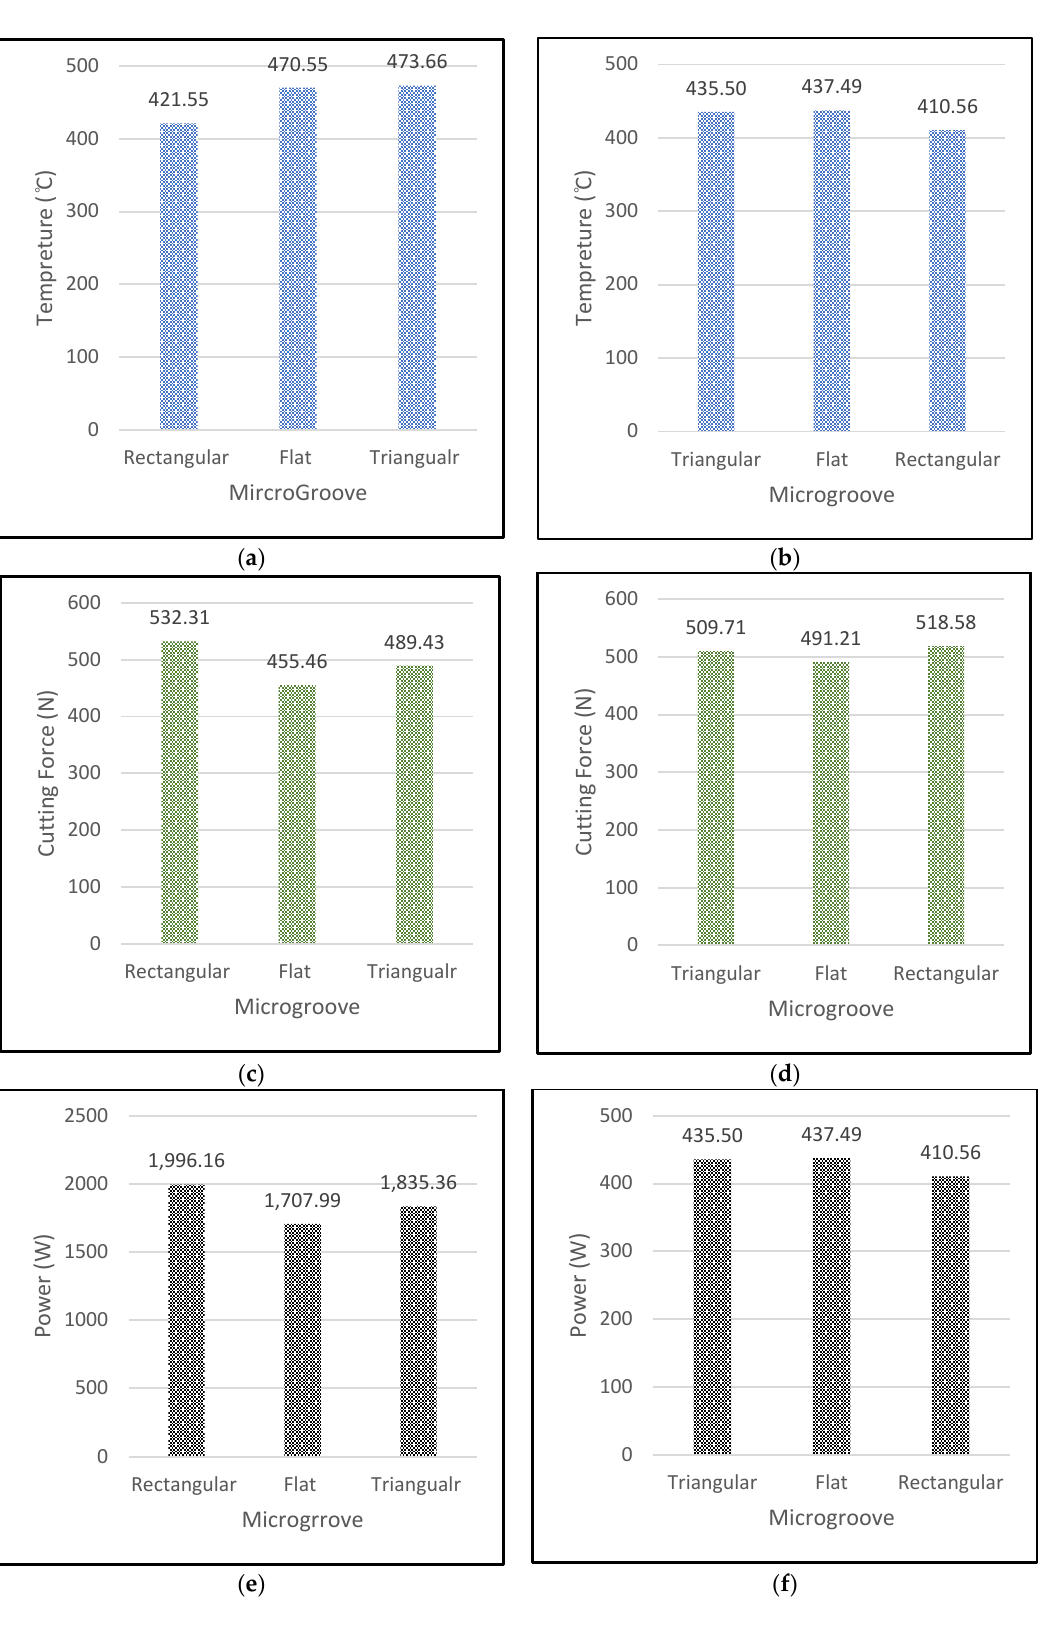
Figure 11. At feed rate of 0.3 mm/rev: ( a ) cutting temperature at v = 225 m/min, ( b ) cutting temperature at v = 75 m/min, ( c ) cutting force ( Fx ) at v = 225 m/min, ( d ) cutting force ( Fx ) at v = 75 m/min, ( e ) cutting power (W) at v = 225 m/min, ( f ) cutting power (W) at v = 75 m/min.